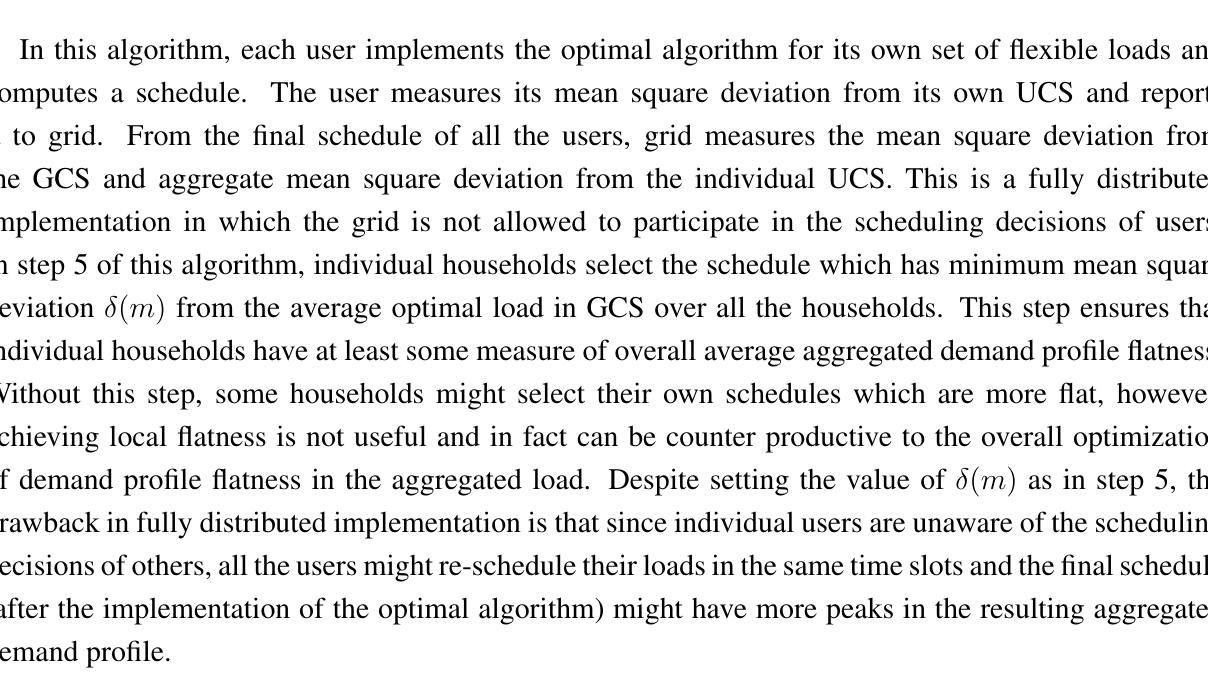
Algorithm 5 Fully Distributed